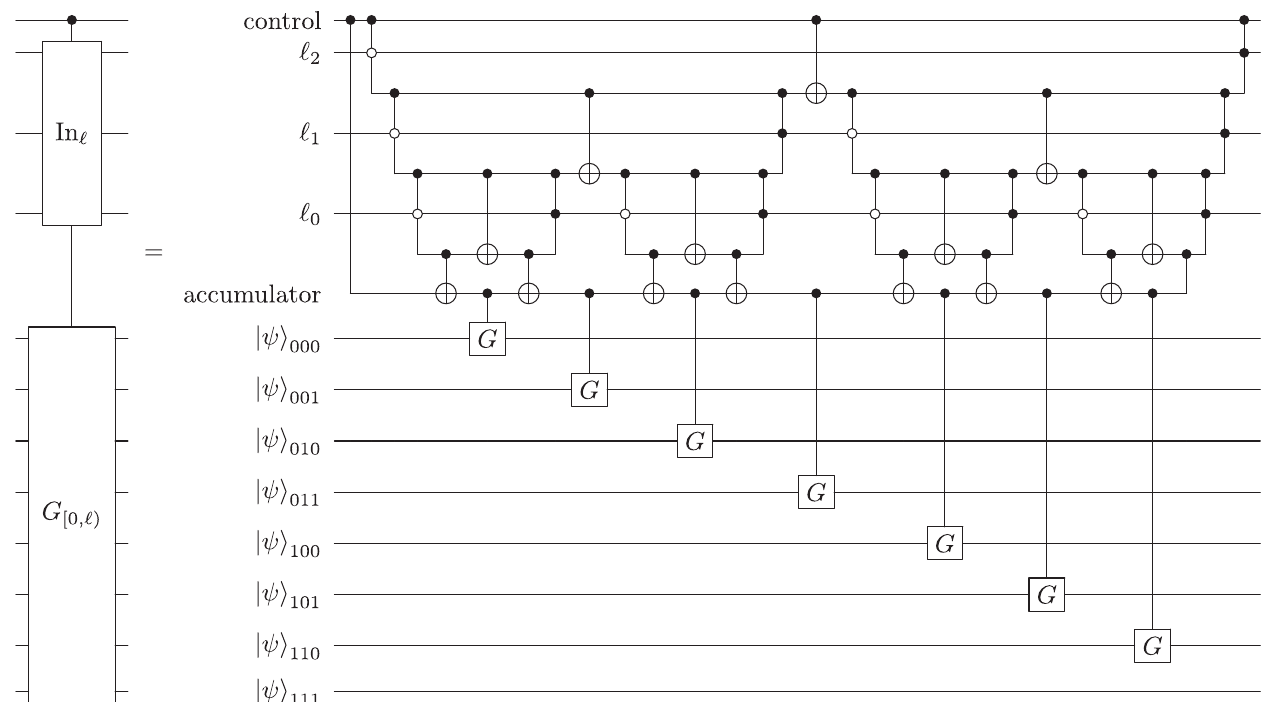
FIG. 8. Ranged operation construction implementing j l ij ψ i → j l i of to a single value, by using an accumulator. The accumulator is guaranteed to be cleared after the final CNOT targeting it (drawn as a line merging into an ancilla qubit). This occurs because (unless CONTROL is not set and the accumulator simply stays unset) exactly one of the unary bits must have been set, and we targeted the accumulator with CNOT s controlled by each of those bits in turn. Note that G refers to G being applied to every qubit index k satisfying p ≤ k < q .